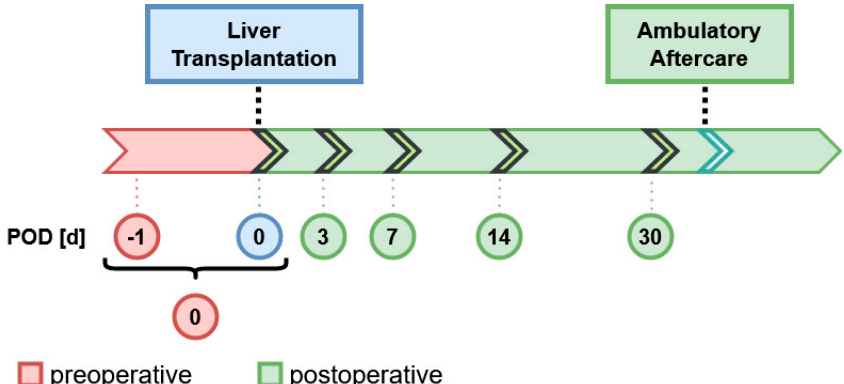
Figure 1. Sampling scheme for patients undergoing liver transplantation (LT). The first serum sample was taken at day of LT, including a time frame of 24 h before, designated as postoperative day 0 (POD 0). Consecutive samples post-LT were collected on the 3rd, 7th, 14th and 30th day post-LT (POD 3, 7, 14, 30).